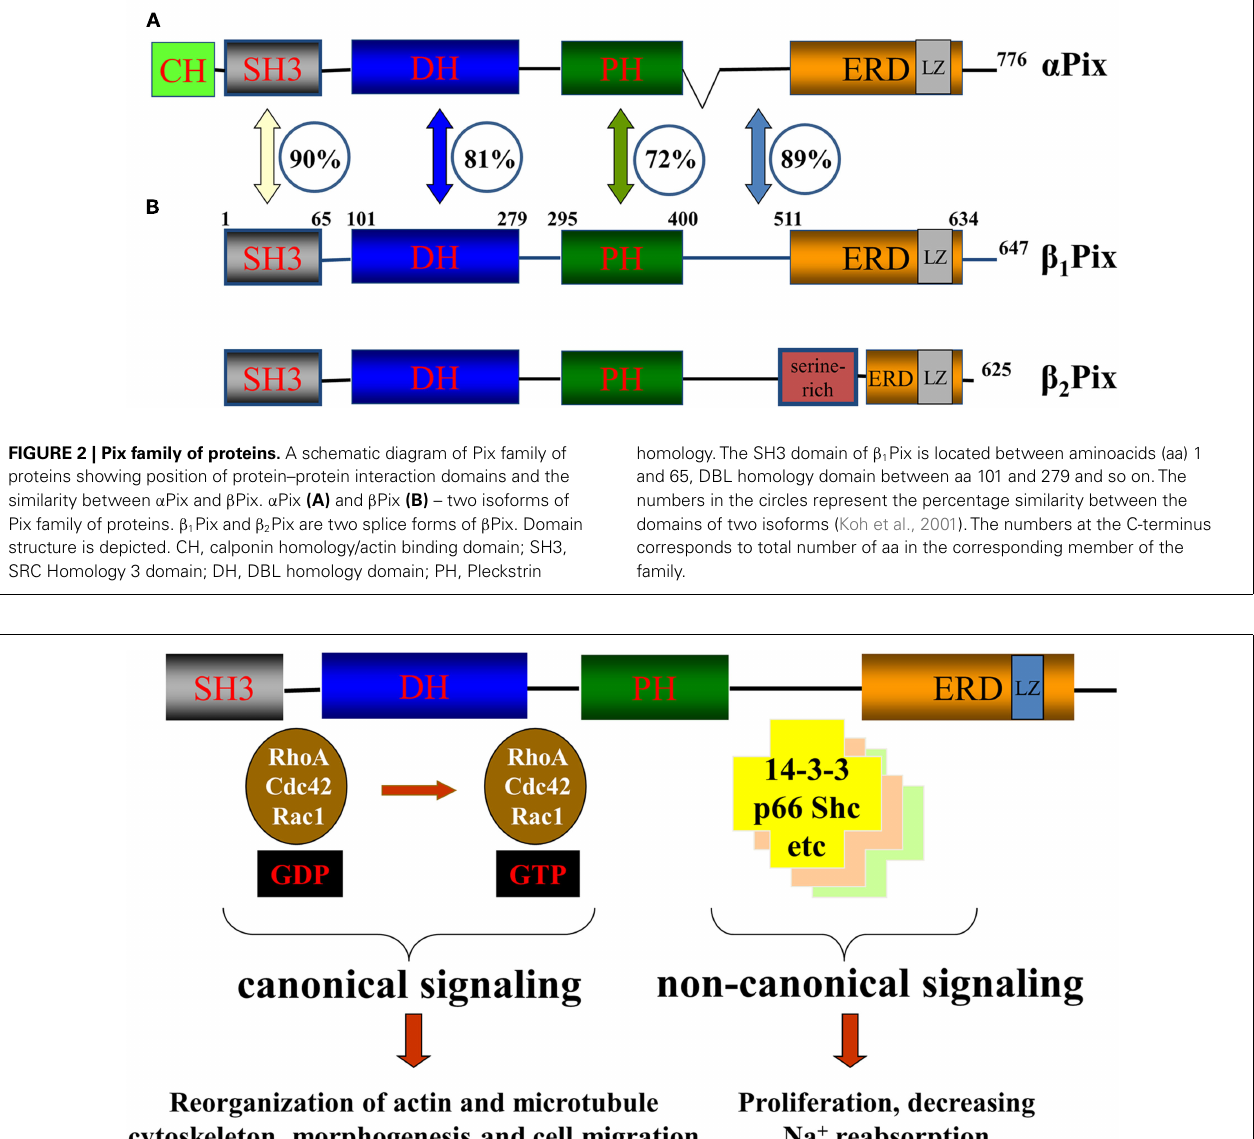
FIGURE 3 | β Pix canonical and non-canonical signaling. Canonical signaling by β Pix is based on its action as a GEF for Cdc42 and Rac1. Non-canonical signaling is based on its ability to act as a scaffolding protein to promote formation of multiunit signaling